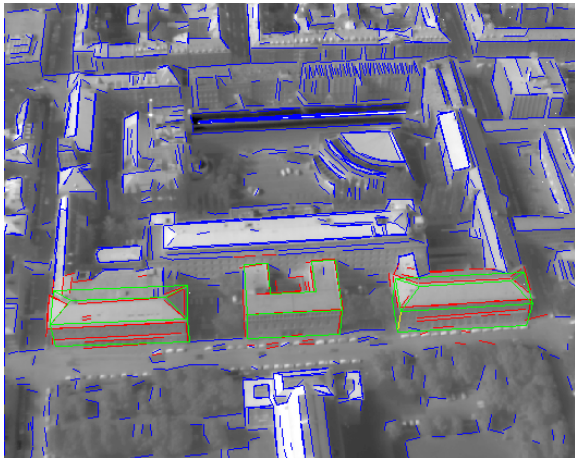
Figure 2. Gradient image, the projected line (cyan) and buffer points (red). The coordinates of the buffer points and the gradient value of their nearest neighbors are taken for adjustment.